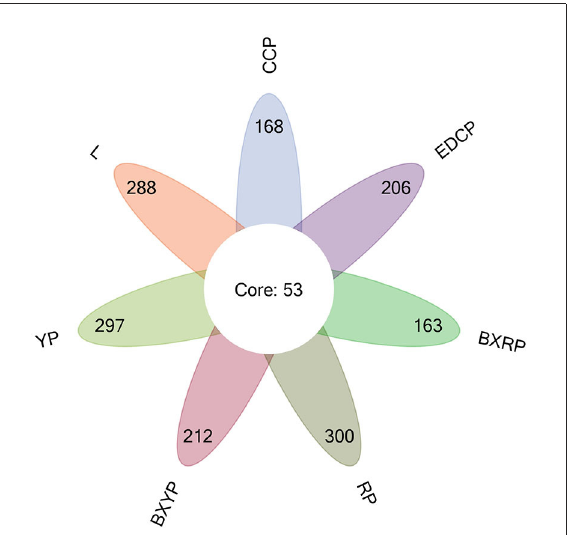
FIGURE3 Venn diagram of seven samples based on OTUs (CCP, female adult ticks; L, eggs, YP, larval ticks; BXYP, engorged larval ticks; RP, nymphal ticks; BXRP, engorged nymphal ticks; EDCP, second-generation adult ticks).